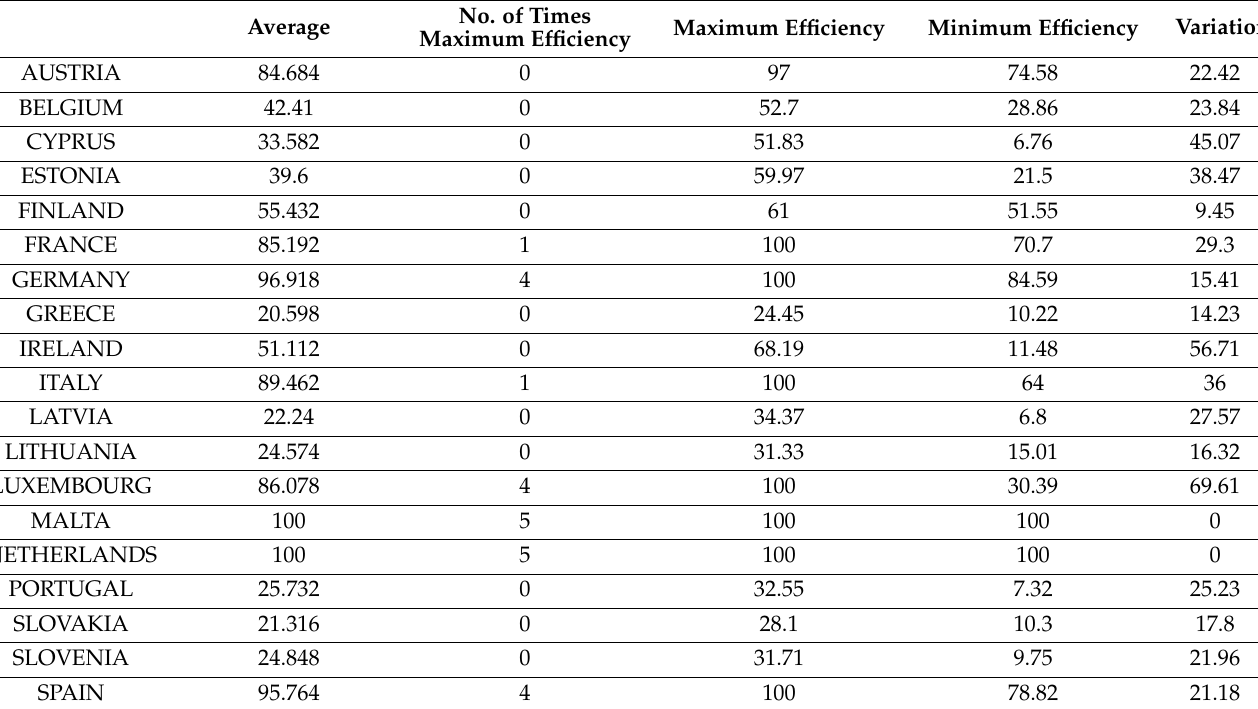
Table 6. Average efficiency of the countries of the Eurozone (2014–2018).